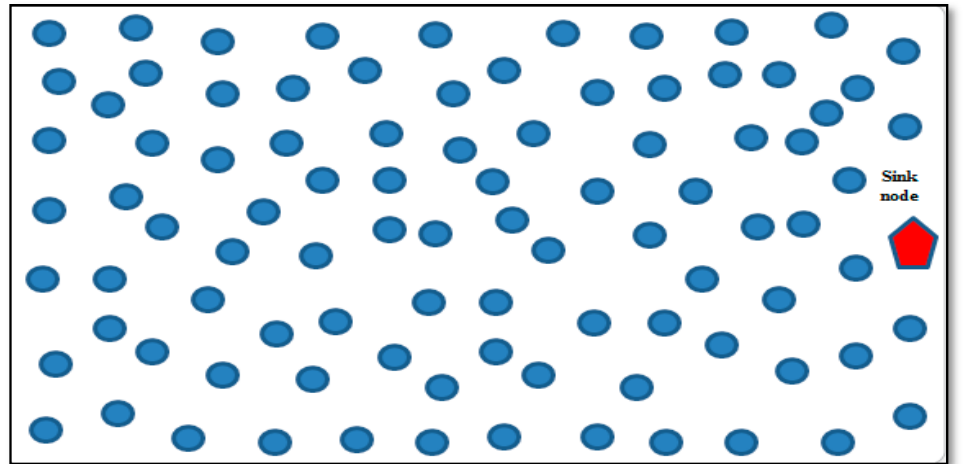
Figure 1. Wireless multimedia sensor network model.